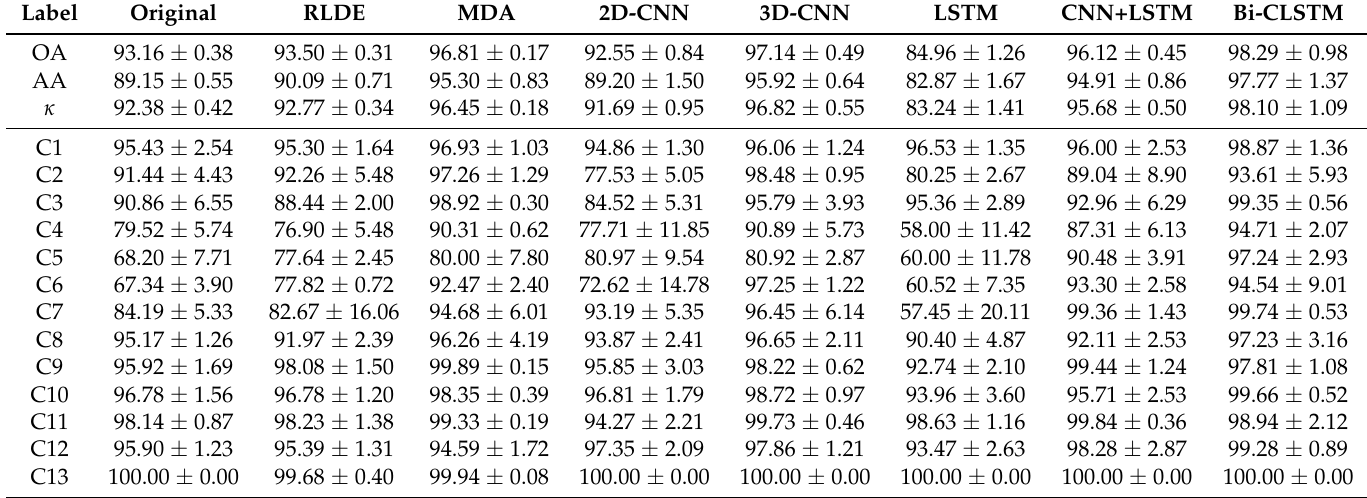
Table 11. OA, AA, per-class accuracy (%), κ and standard deviations after five runs performed by eight methods on the KSC dataset using 10% pixels from each class as the training